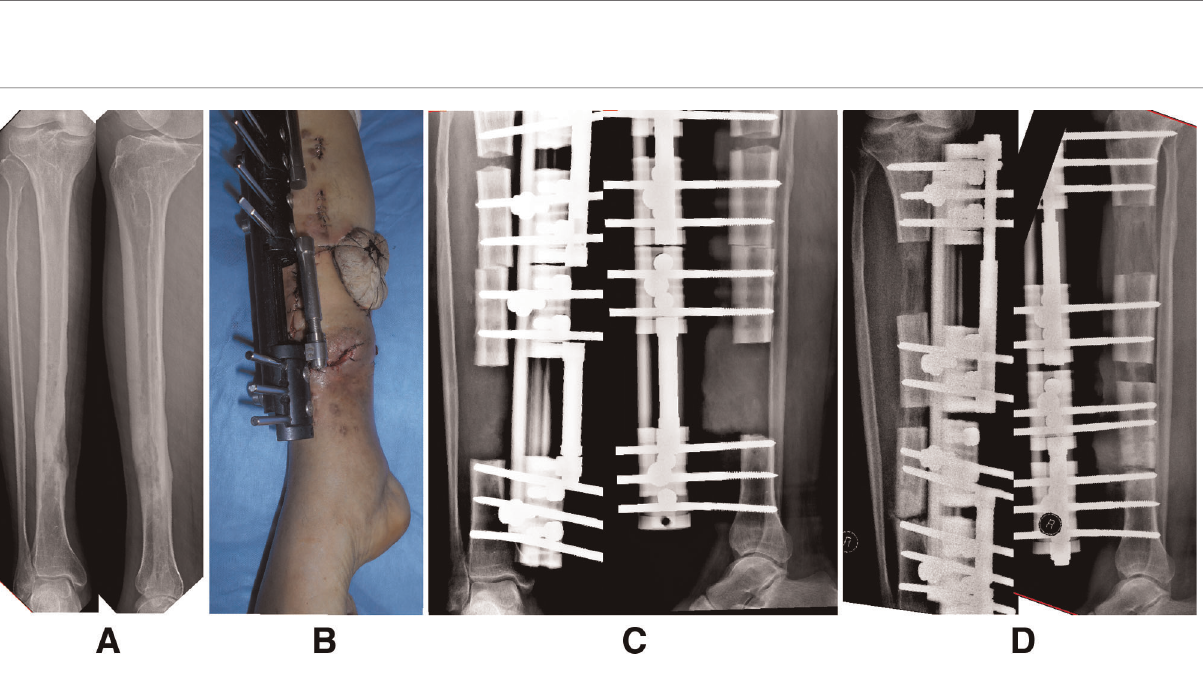
FIGURE 4 | A 53-year-old man suffered chronic osteomyelitis in his right tibia after internal fi xation treatment due to a crushing injury caused by a heavy object and was successfully managed by the trifocal bone transport technique (tandem transport, from proximal to distal). ( A ) Preoperative radiographs indicated that the infectious lesion was located at the distal one-third of the tibial shaft. ( B ) Removal of devitalized bone and soft tissue by radical debridement; the soft tissue defect was treated by using a local tissue fl ap. ( C ) There were 9-cm bone defects, and a trifocal tandem bone transport from proximal to distal was conducted for the limb